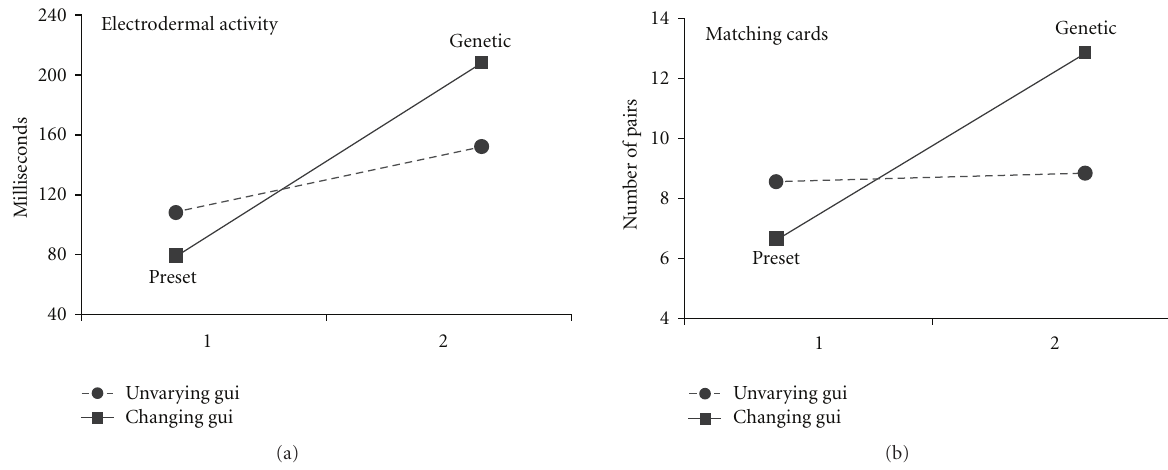
Figure 5: Arousal levels and numbers of card pairs solved for the first (1) and second (2)